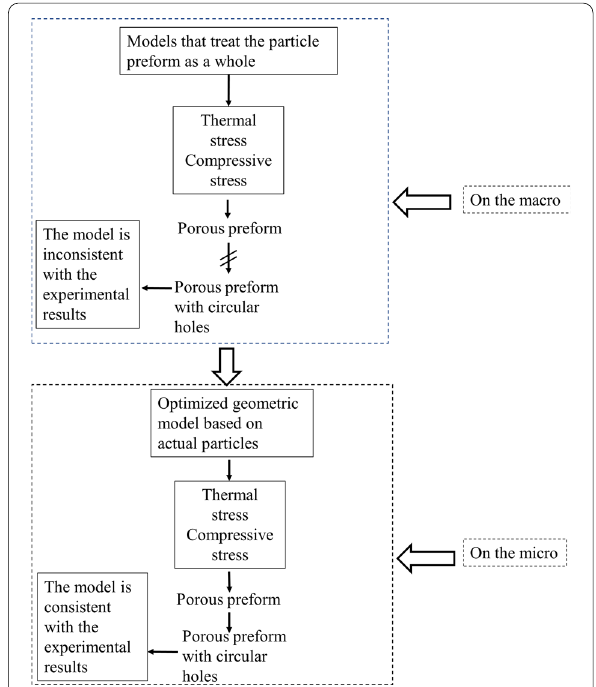
Fig.1 The flowchart of geometric model optimization for HCCI/ZTA P